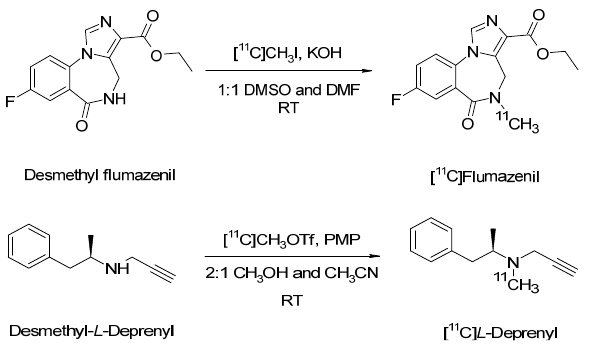
Figure 4. Reaction schematic for [ 11 C]flumazenil and [ 11 C] L -deprenyl synthesis. Only reactor R1 was explored for the radiochemical reaction. Required reagents were placed on the vial holder in the following vial positions. For HPLC injection, vial B was filled with 800 µL of 65% ethanol; vial E was filled with 100 µL (200 µg) of precursor in a 1:1 mixture of DMSO and DMF with powdered KOH for flumazenil and a 2:1 mixture of methanol and acetonitrile with PMP base for deprenyl. Vial F was filled with 400 µL of 100% ethanol for final product elution from R4. Vial G was filled with 5 mL of 0.9% saline or phosphate-buffered saline (PBS) for formulation. Vial H was filled with 10–12 mL of sterile water for product dilution from the HPLC, and vial I was filled with 2 mL of water to wash reactor R4.